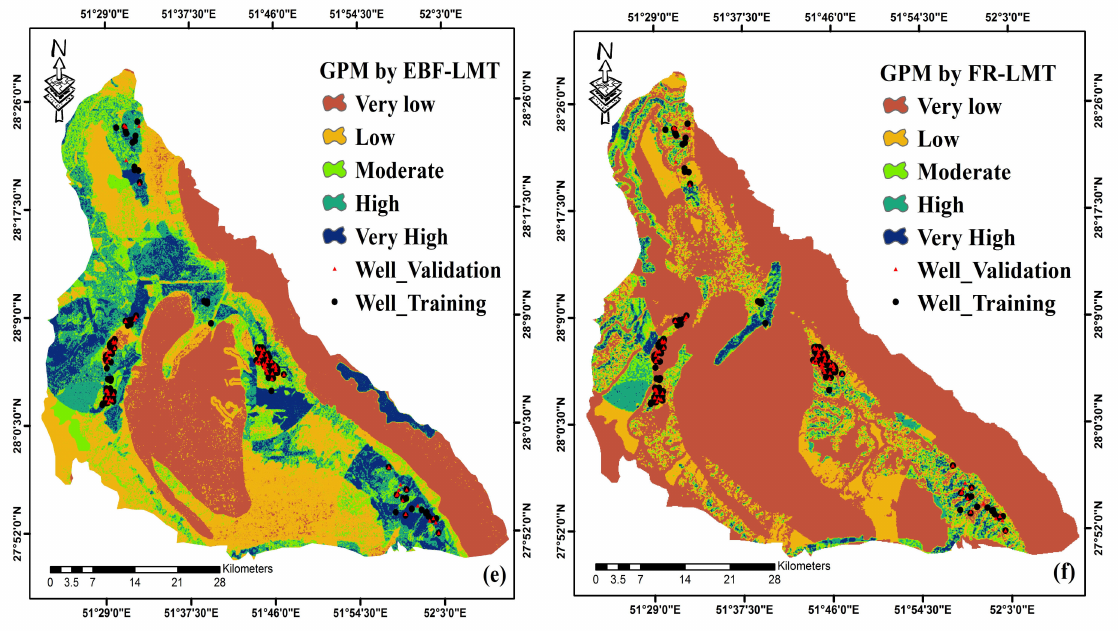
Figure 6. Groundwater potential map (GPM) of the Booshehr plain made from ( a ) certainty factor (CF)-RF, ( b ) evidential belief function (EBF)-RF, ( c ) frequency ratio (FR)-RF, ( d ) CF-LMT, ( e ) EBF-LMT and ( f ) FR-LMT models.